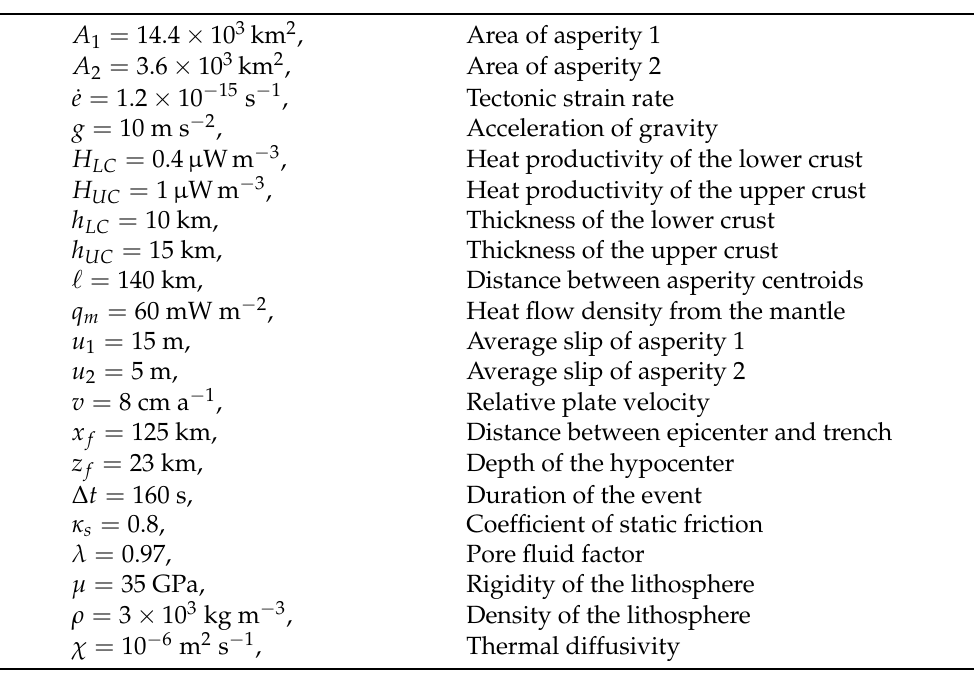
Table 1. Data of the 2010 Maule (Chile) earthquake.